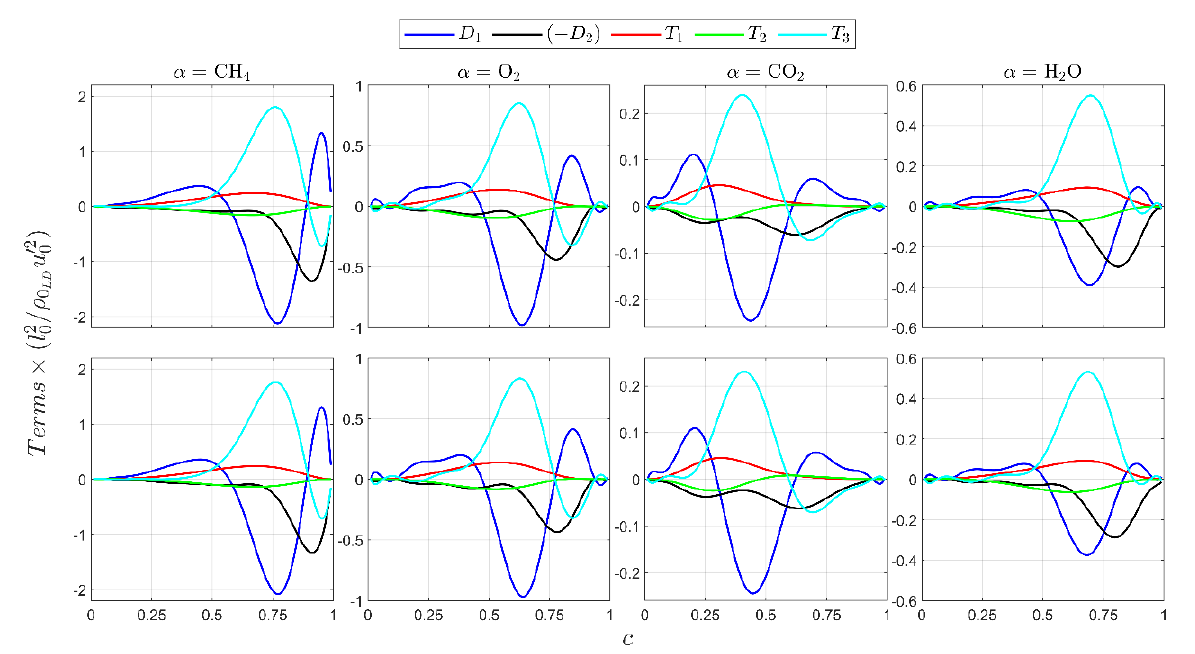
Figure 7. Profiles of the mean contributions of the terms on the right-hand side of the SDR transport equation (i.e., {𝐷 1 , 𝑇 1 , 𝑇 2 , 𝑇 3 , −𝐷 2 } × 𝑙 02 /𝜌 0 𝑢 0′ 2 ) conditioned upon 𝑐 for different definitions of reaction progress variable c for premixed combustion cases with initial u (cid:48) / S L = 4.0 (1 st row) and 8.0 (2 nd row).